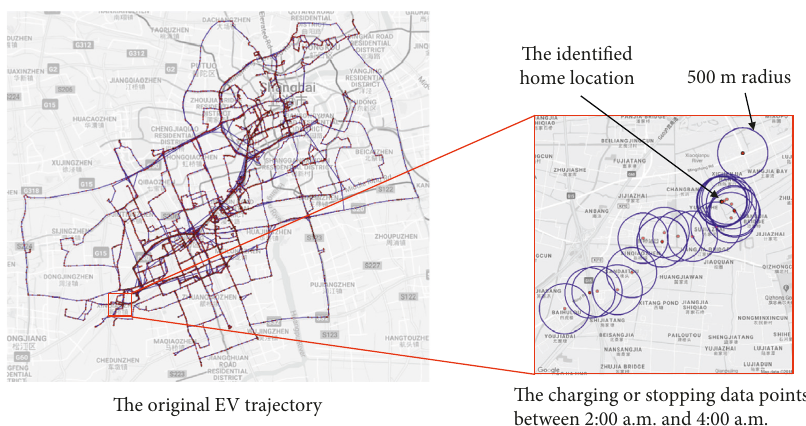
Figure 4: Home location identification based on EV trajectory data.